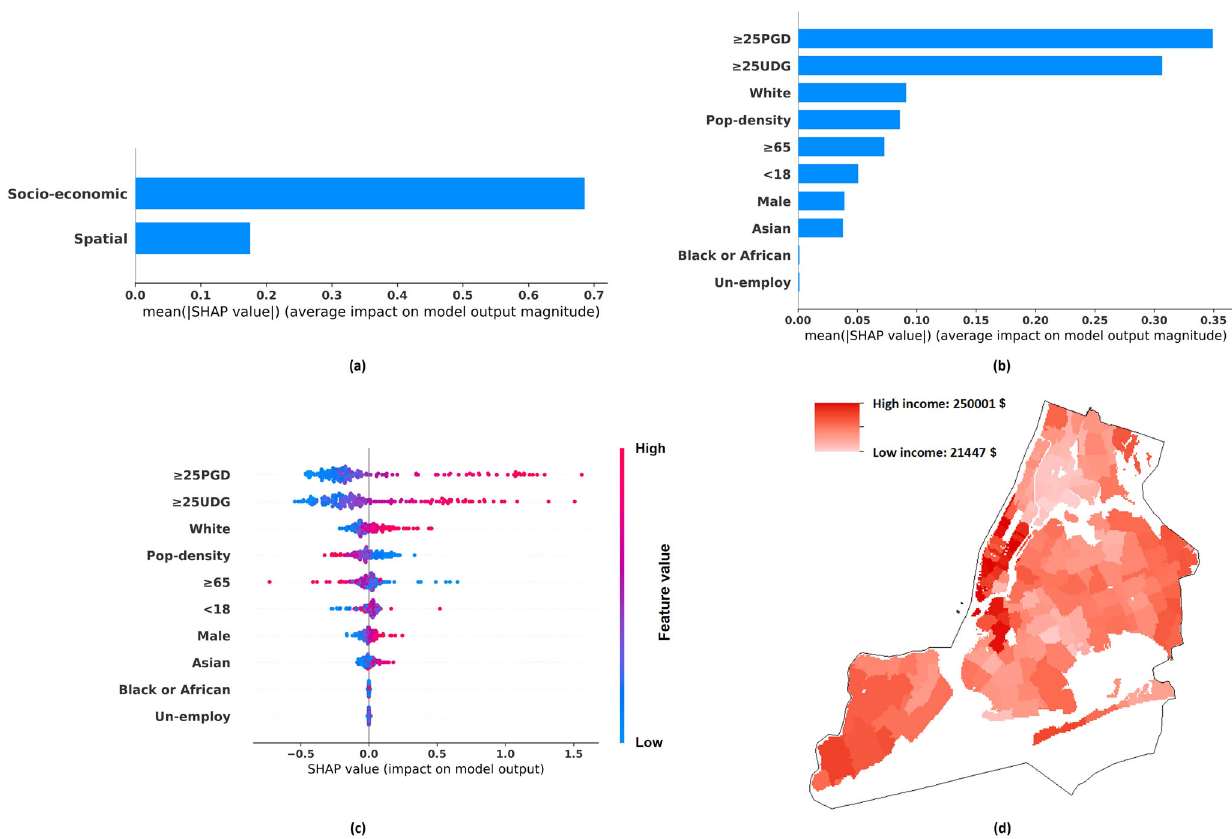
Fig. 5 ZIP-level median household income distribution and SHAP analysis results. a The mean absolute SHAP value indicating the total contribution of spatial or socio-economic features to ZIP-level median household income estimation. b The mean absolute SHAP value indicating the contribution of individual socio-economic features to ZIP-level median household income estimation. c The SHAP value indicating the contribution of individual socio- economic features to ZIP-level median household income estimation, with each dot corresponding to a value of a particular ZIP region. d ZIP-level median household income